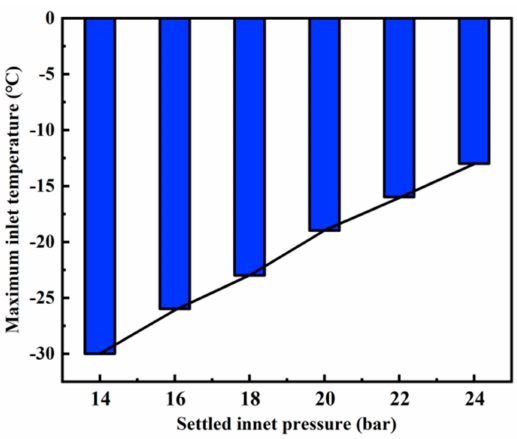
Figure 10. Maximum allowable inlet temperature corresponding to each inlet